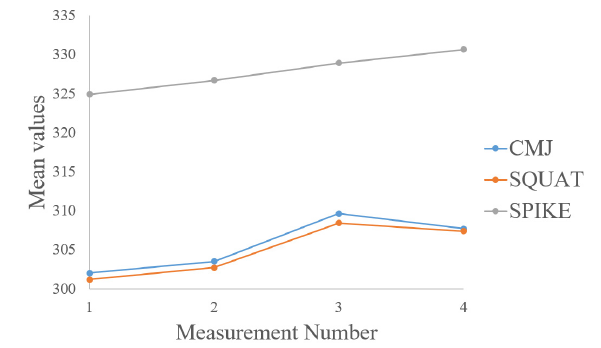
Fig. 1. The changing of the vertical jump values.